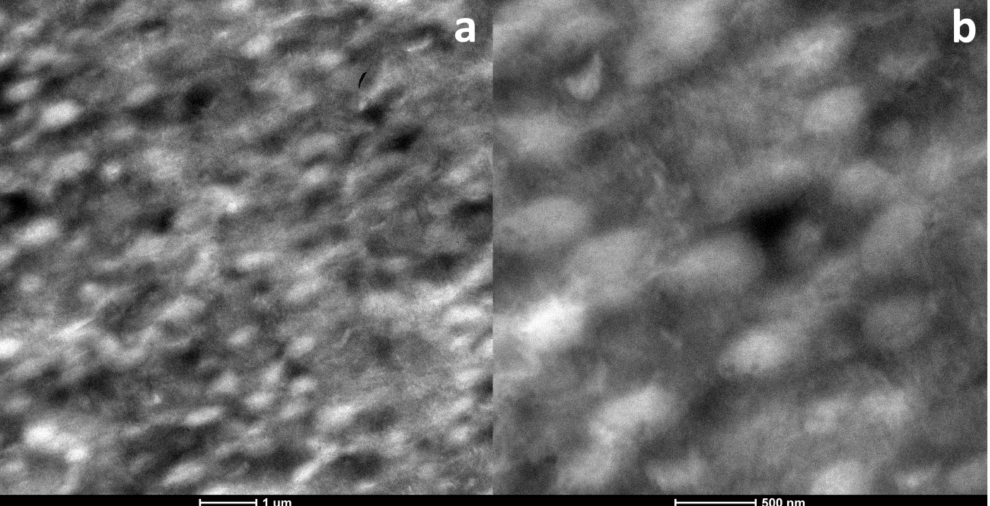
Figure 4. TEM micrographs of the PA410/Pebax 70/30 blend: ( a ) At × 5000 magnification; ( b ) at × 14,500 magnification.